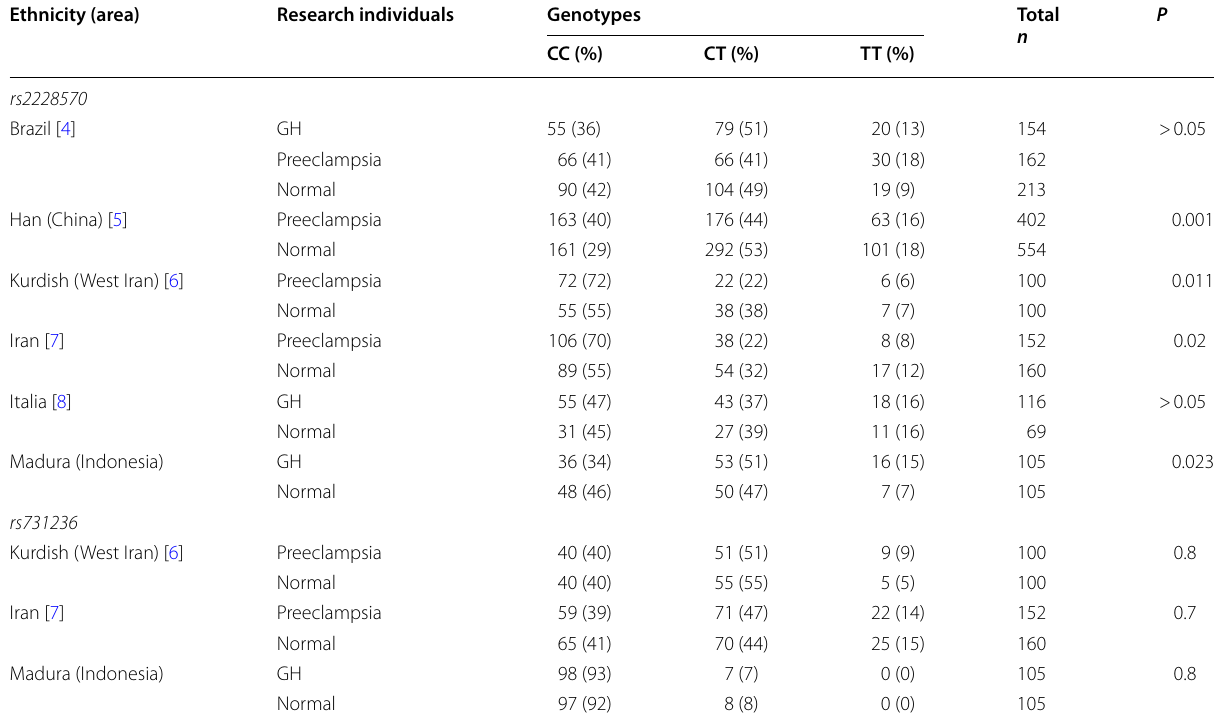
GH gestational hypertention =